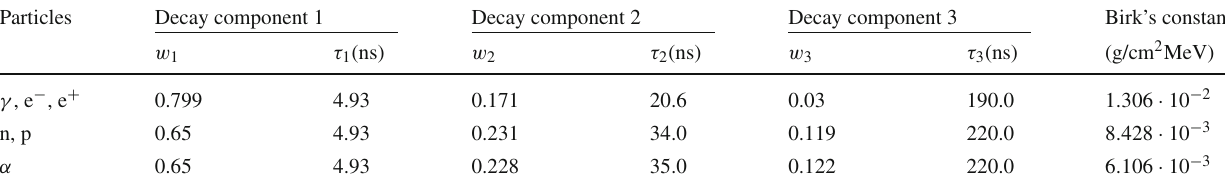
Table 3 Scintillator specific light emission properties depending on the particle type [17] Particles Decay component